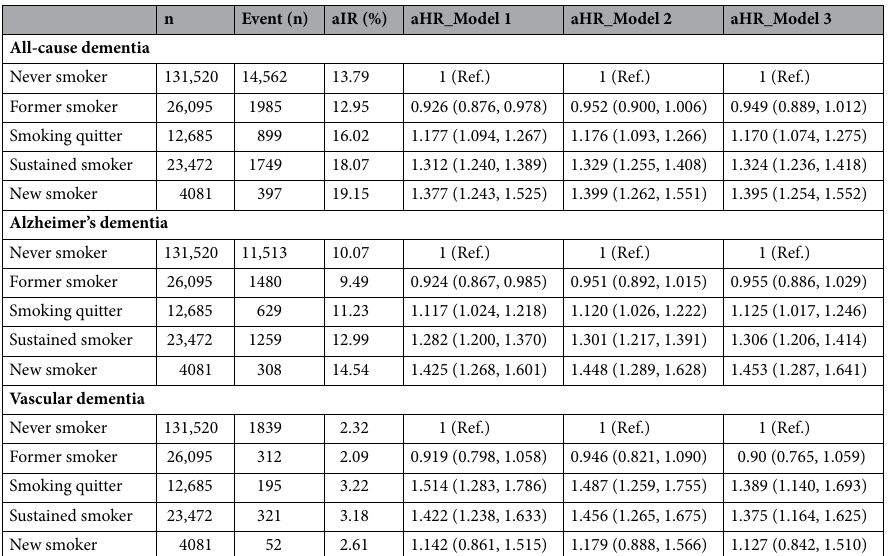
dementia occurred in 14,562 (26.53/1000 PY), 1985 (18.89/1000 PY), 899 (17.26/1000 PY), 397 (23.50/1000 PY), and 1749 (18.14/1000 PY) never smokers, former smokers, smoking quitters, new smokers, and sustained smok- ers, respectively. The adjusted incidence rates of all-cause dementia were 13.79 PY, 12.95 PY, 16.02 PY, 19.15 PY, and 18.07 PY in the never smoker, former smoker, smoking quitter, new smoker, and sustained smoker groups, respectively. The crude incidence rate, crude hazard ratio, and aHR according to the prespecified models for all-cause dementia, AD dementia, and VaD for each group are shown in Table 2. In the multivariate Cox proportional